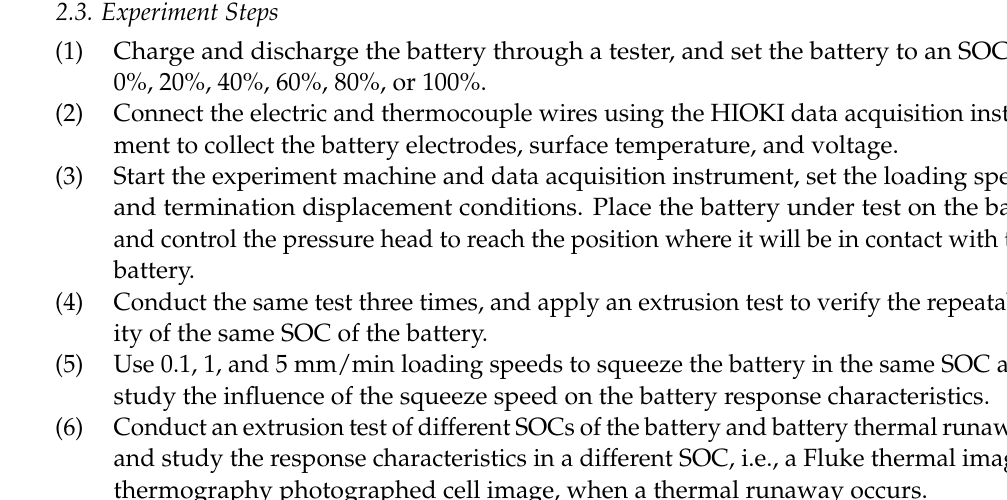
Figure 1. Experimental